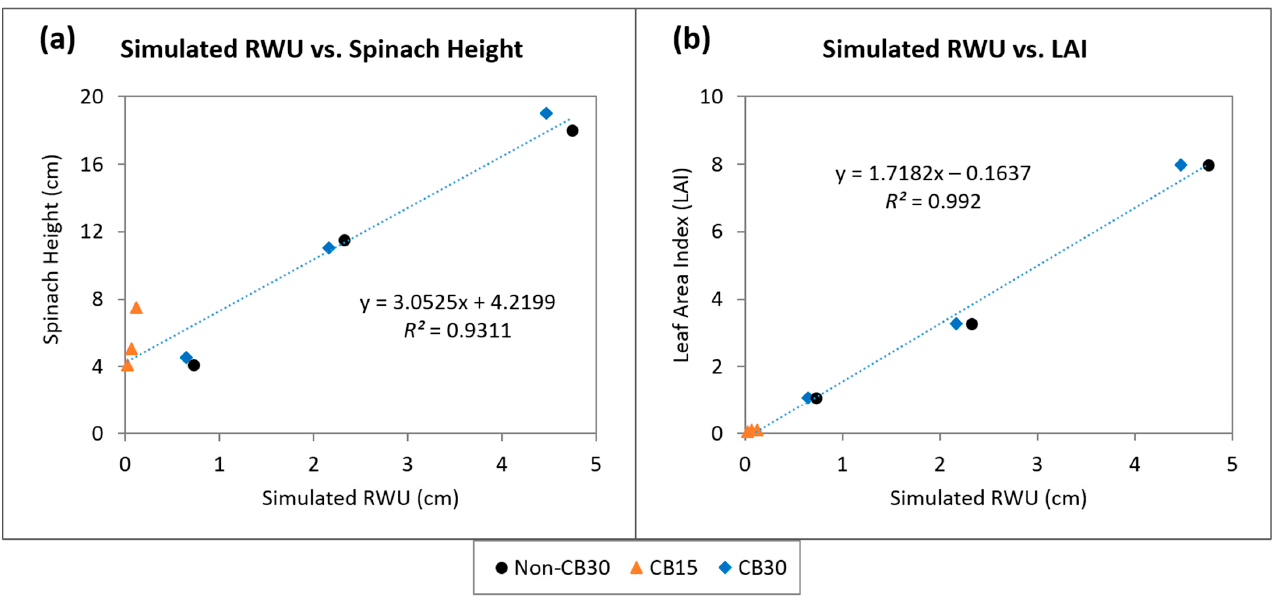
Figure 7. Scatter plot of cumulative RWU simulated by the model versus ( a ) spinach heights and ( b ) leaf area index obtained